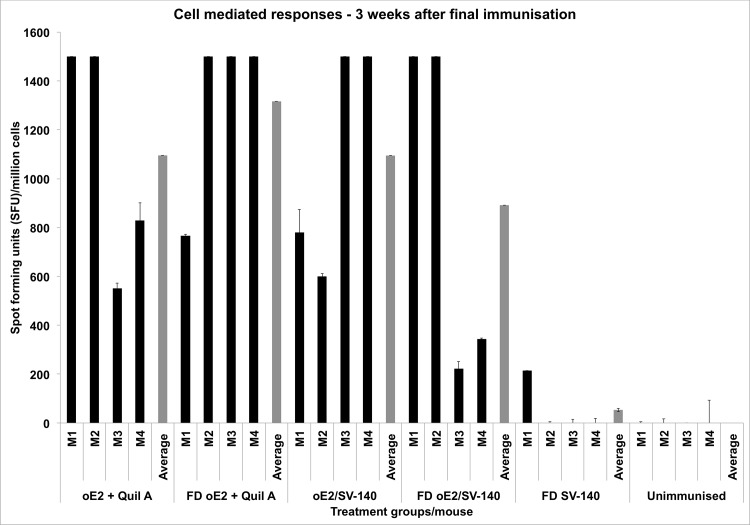
Detection of antigen specific IFN-γ secretion by ELISPOT assay of murine splenocytes from immunised mice.The black bars represent the number of cells producing IFN-γ in response to the oE2 antigen 3 weeks after the final immunisation. The grey bars show the average for each group and M1 to M4 represent the four individual mice in each group.